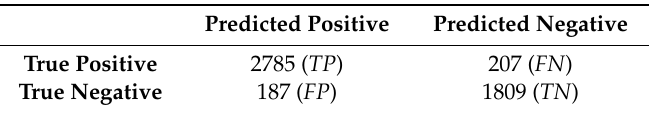
Table 1. Confusion matrix.